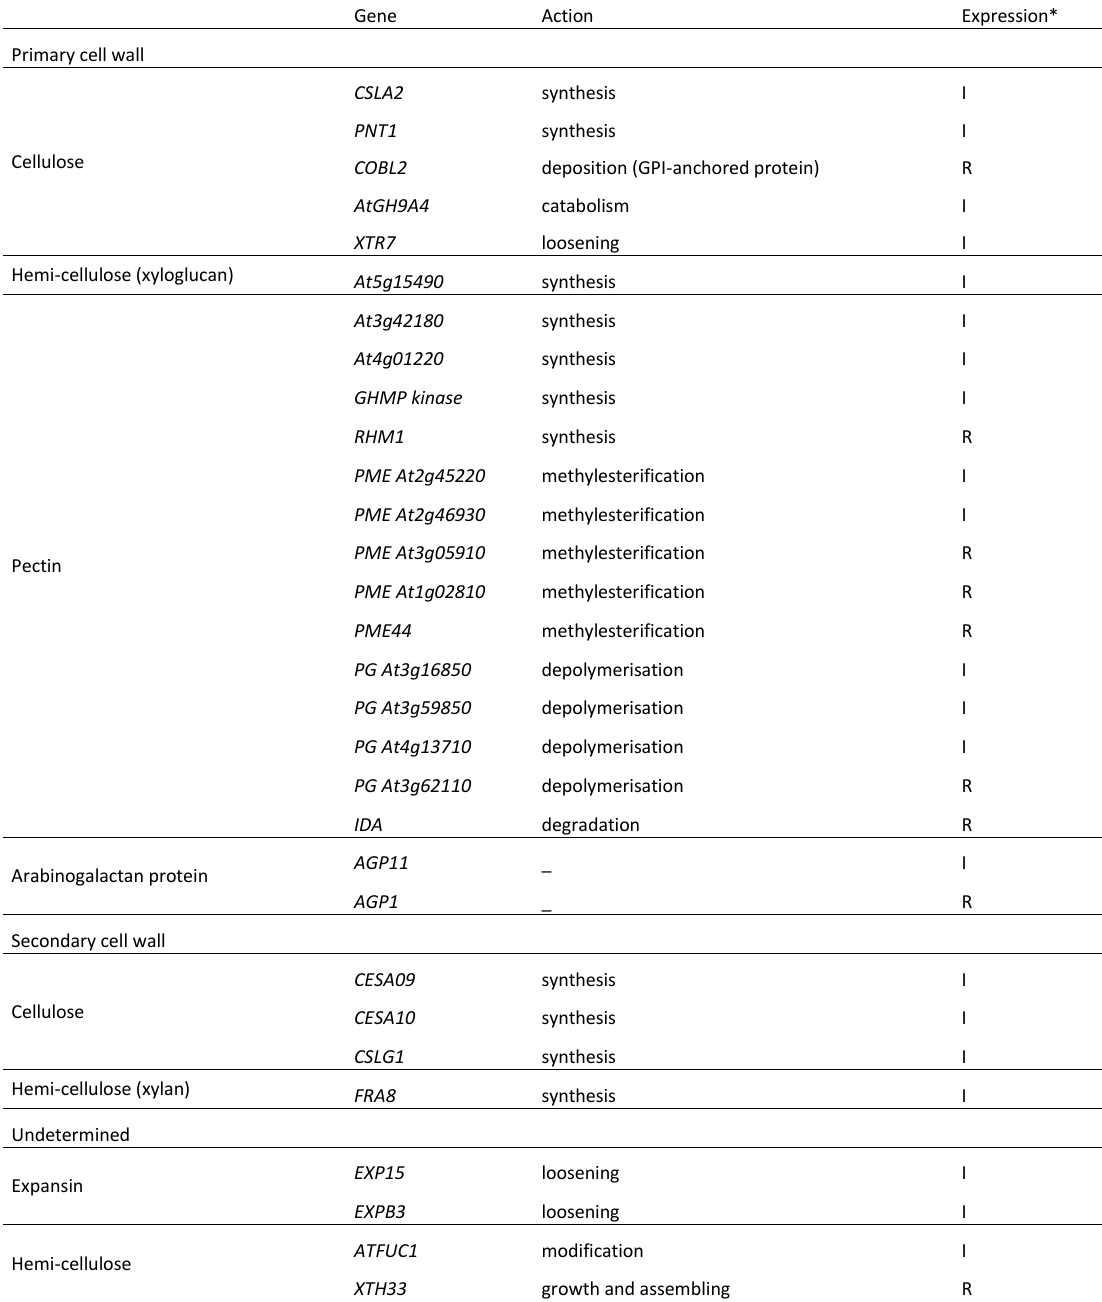
Table 4 : Main DEGs related to cell wall carbohydrates synthesis/modification detected